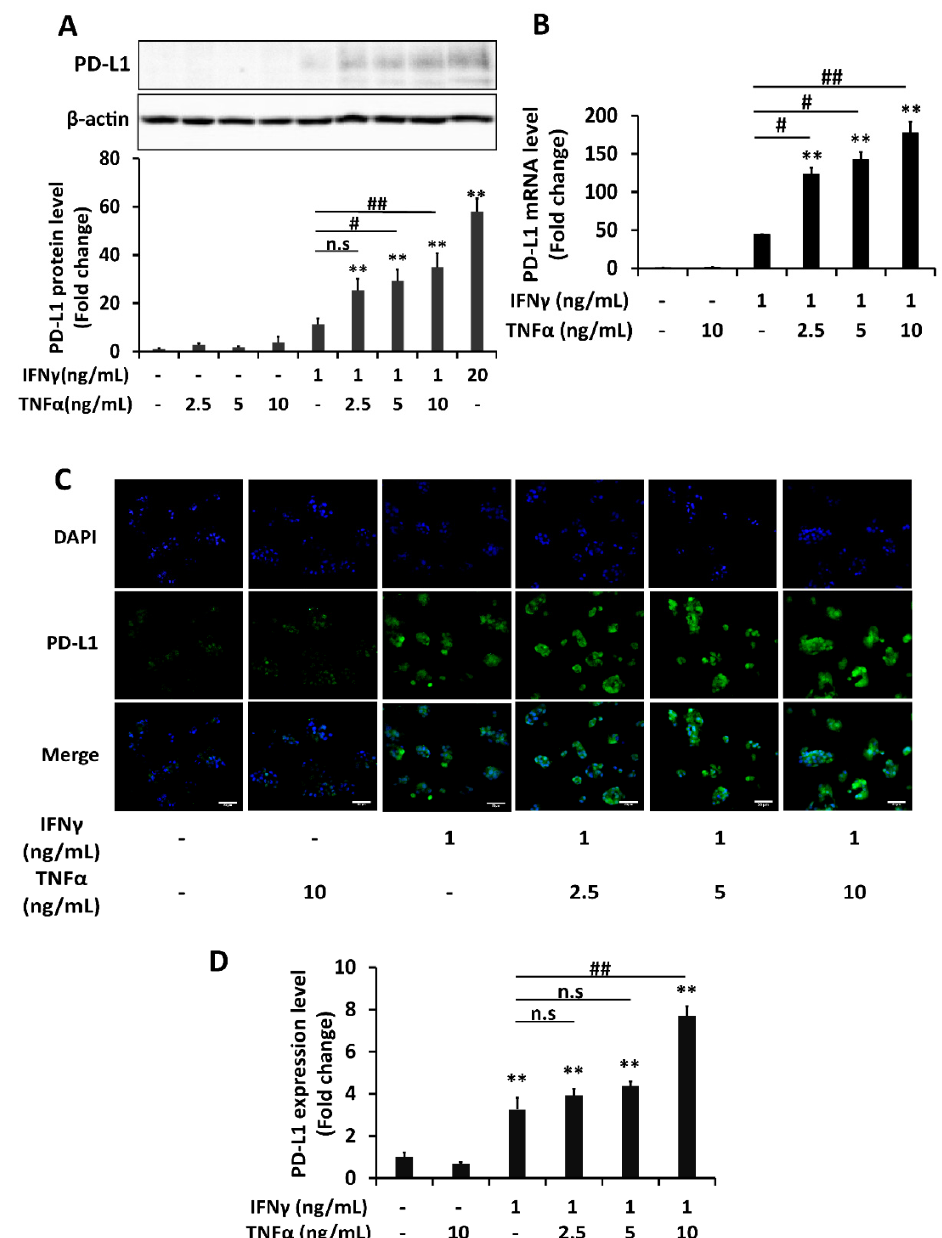
Figure 2. Combination treatment of IFN γ and TNF α synergistically upregulates PD-L1 expression both in mRNA and protein level in HepG2 cells. ( A – D ) Analysis of PD-L1 expression of HepG2 cells treated with either individual or combination of IFN γ and TNF α at various concentrations (ng/mL) for 6 h in RT-PCR analysis and for 24 h in Western blot or immunocytochemistry analysis. ( A ) Western blot analysis and quantification. β -actin was used as a loading control. ( B ) RT-PCR analysis. Relative PD-L1 mRNA level was normalized to the expression of the GAPDH gene. ( C , D ) Immunocytochemistry of PD-L1 membrane expression and its quantification. Scale bar = 50 µ m. Data are presented as mean ± SD for WB and RT-PCR; mean ± SEM for Immunocytochemistry. n = 3. * p < 0.05, ** p < 0.01 compared to control. # p < 0.05, ## p < 0.01 compared to IFN γ single treatment.